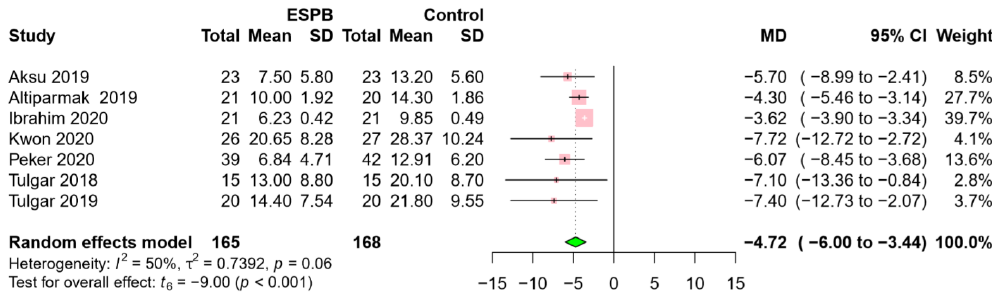
Figure 3. Forest plot for 24 h postoperative opioid consumption. Opioid consumption was significantly lower in the ESPB group than in the control group. Abbreviations: ESPB, erector spinae plane block; MD, mean di ff erence; SD, standard deviation; CI, confidence interval.